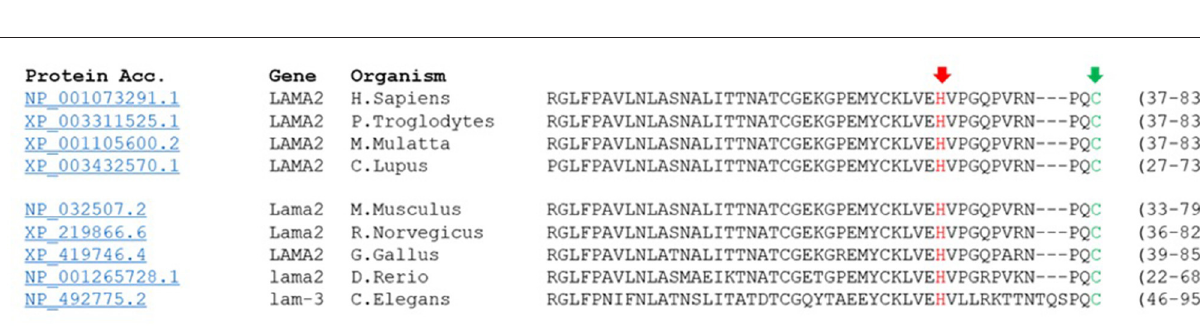
FIGURE 5 | Brain MRI revealed white matter lesions typical for LAMA2-associated diseases. T2-weighted sagittal (A) and axial (B) brain MRI images revealed confluent hyperintense lesions predominantly in the periventricular white matter with involvement of the subcortical U fibers. The corpus callosum was spared, the ventricles are not enlarged and no other intracranial malformations were present (C) on FLAIR-weighted axial scan.